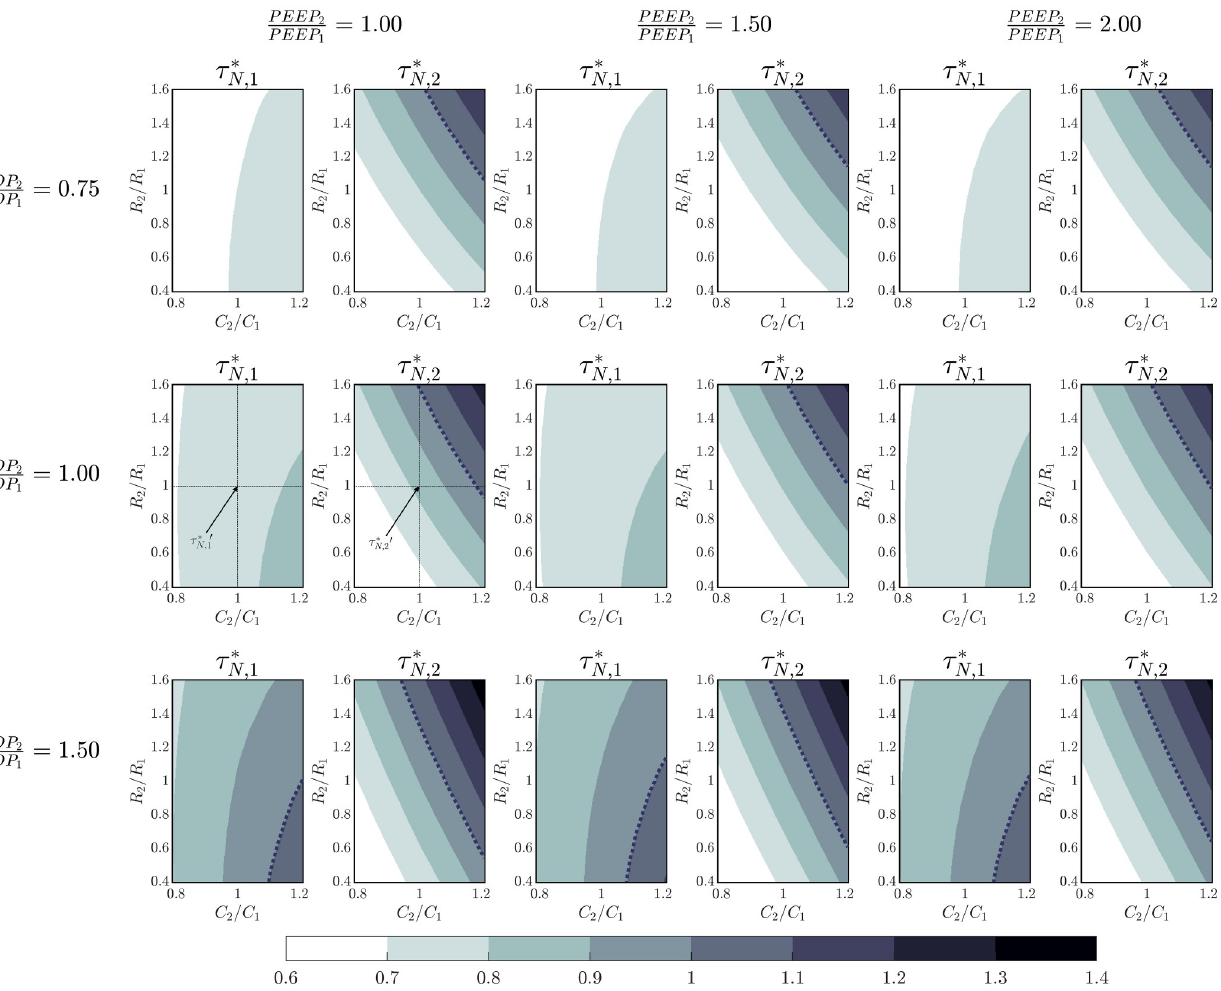
Fig 10. Characteristic exhalation times mapping for R V / R 1 = 0.3 and for different patients’ lungs mechanics combinations. The dashed line represents the auto-PEEP limit.